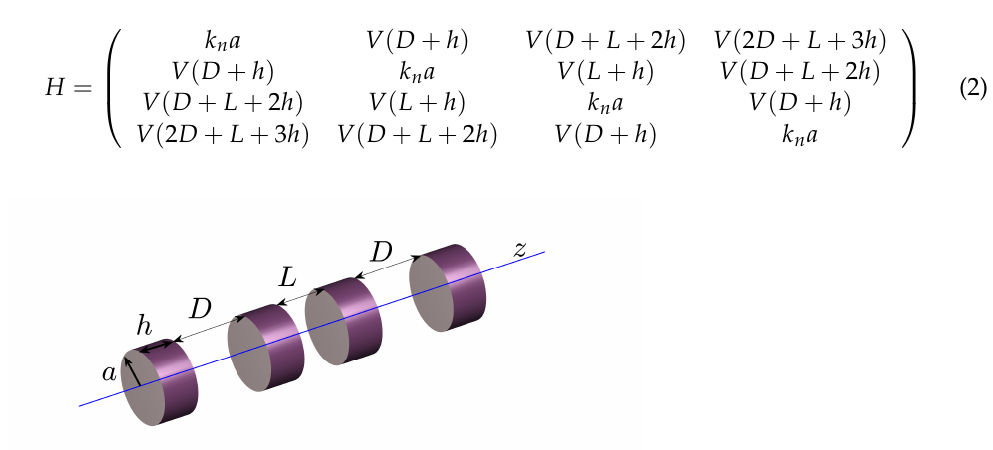
Figure 2. Four coaxial dielectric disks with (cid:101) = 12 and h / a = 1.04 arranged in two dimers. The space parameters of disks and distances between them are given in terms of the disk radius a